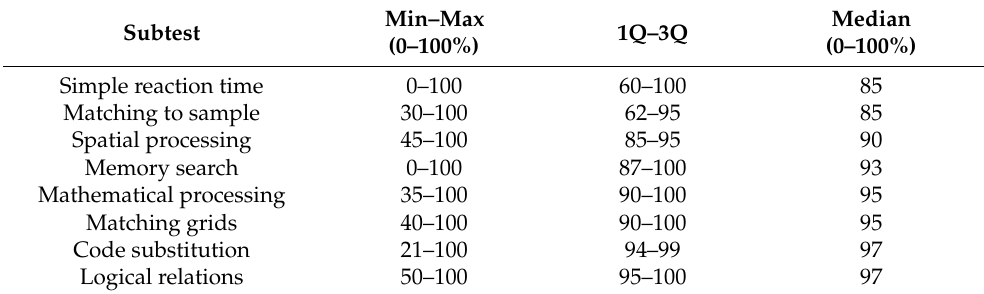
Table 3. Descriptive analysis of the percentage of correct answers of all participants in each Ped- ANAM subtest (N =